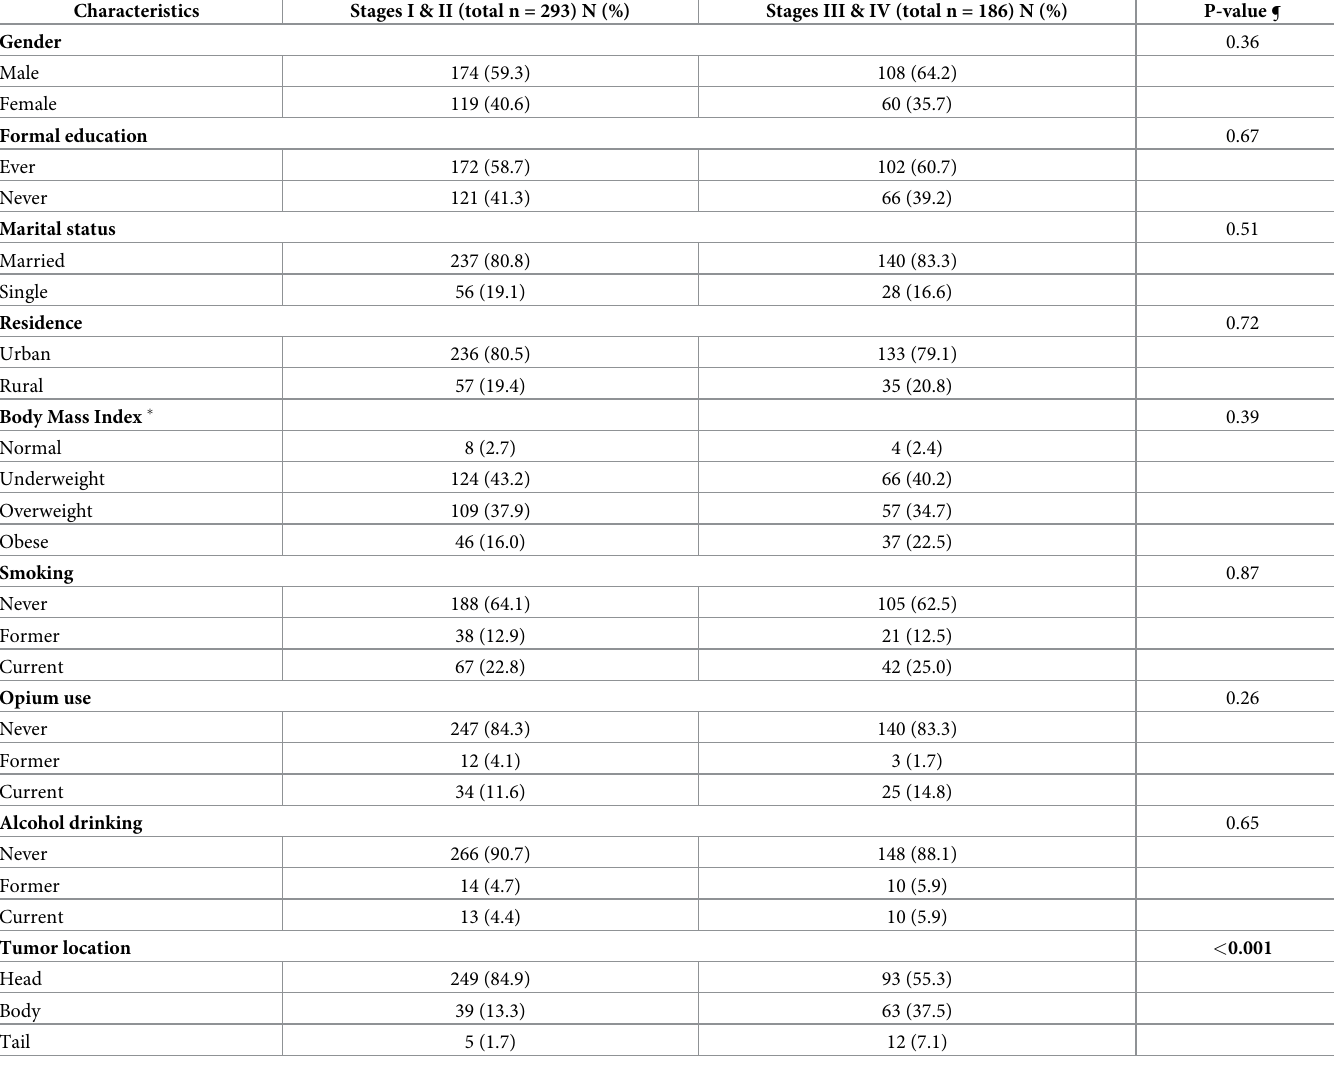
Table 2. Associations between different demographics and tumor characteristics with the tumor stage at diagnosis among Iranian patients with pancreatic ductal adenocarcinoma.